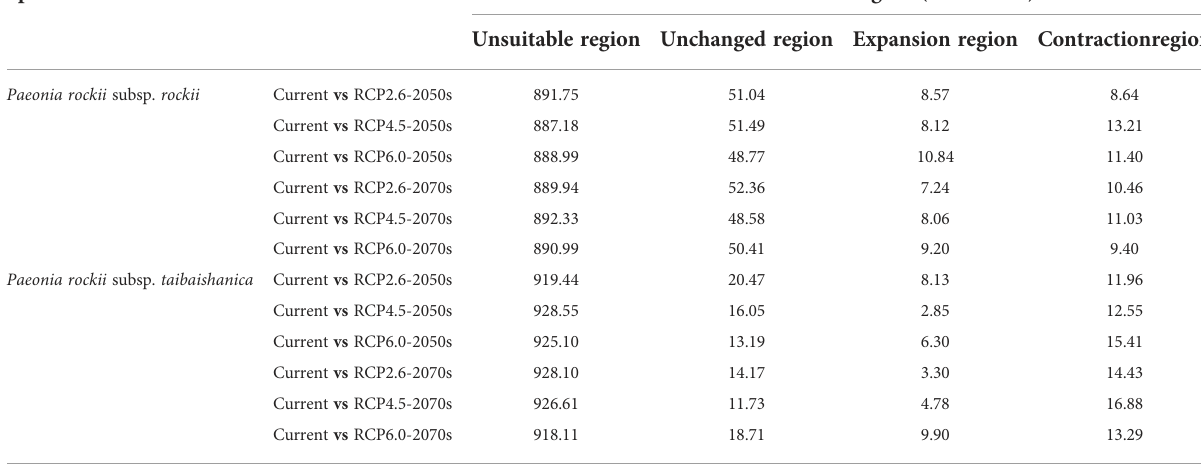
TABLE 5 The potential distribution area of the two Paeonia species in the 2050s and 2070s.